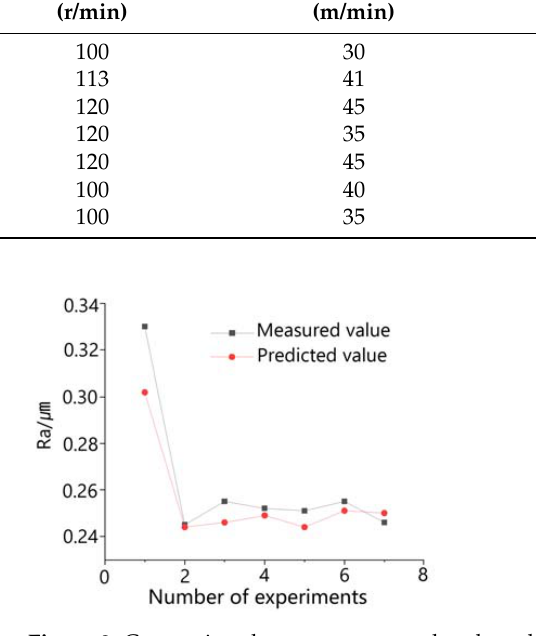
( b ) Figure 11. ( a ) Surface morphology before optimization, ( b ) surface morphology after optimization. 6. Conclusions Based on GRA and RSM, this paper analyzed the influence of honing parameters of carburized alloy steel on surface quality and obtained the optimal honing parameters with the minimum roughness Ra value. The specific conclusions are as follows: (i)